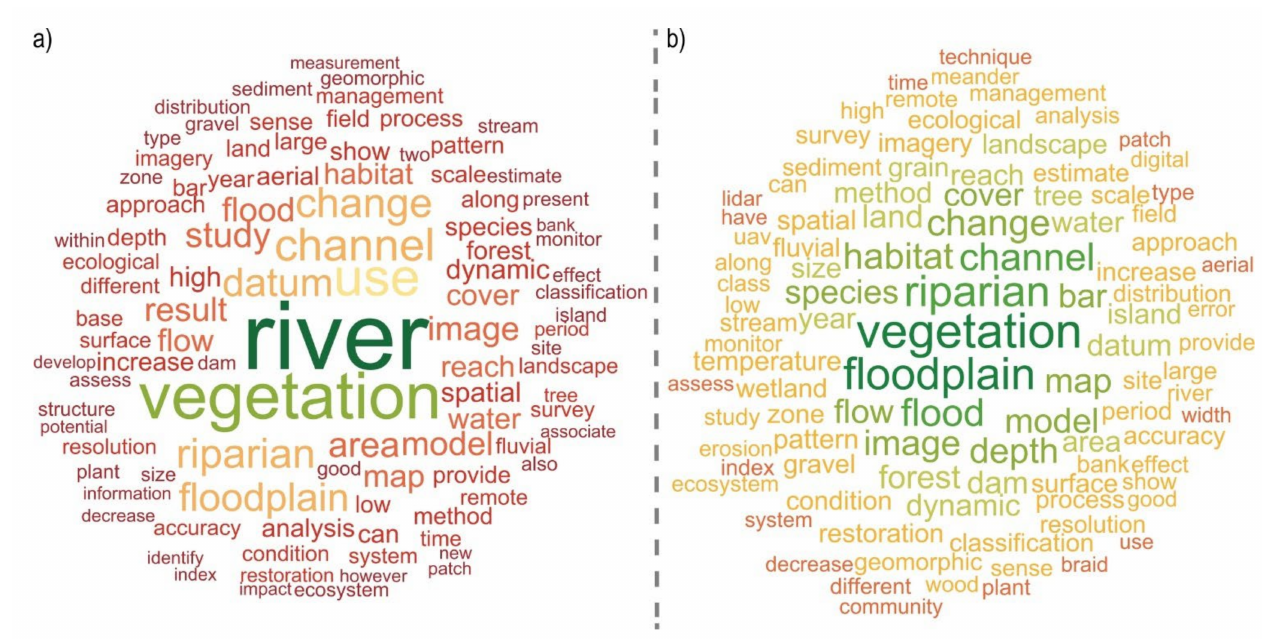
Figure 5. Term frequency ( a ) and term frequency-inverse document frequency ( b ) of the primary corpus. The size of the term is proportional to the term frequency and to the tf-idf values obtained. Word importance (tf-idf values) differed when the primary corpus was divided into four manually selected clusters based on the remote sensing sensors used (Figure